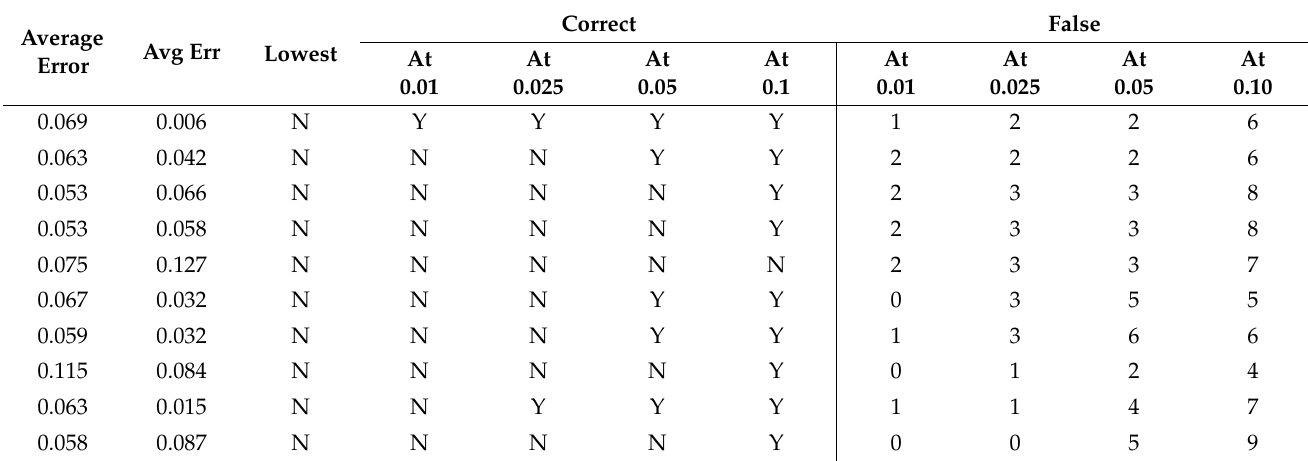
Table A30. Set 1, trials 11–20 summary data (actual PR value).